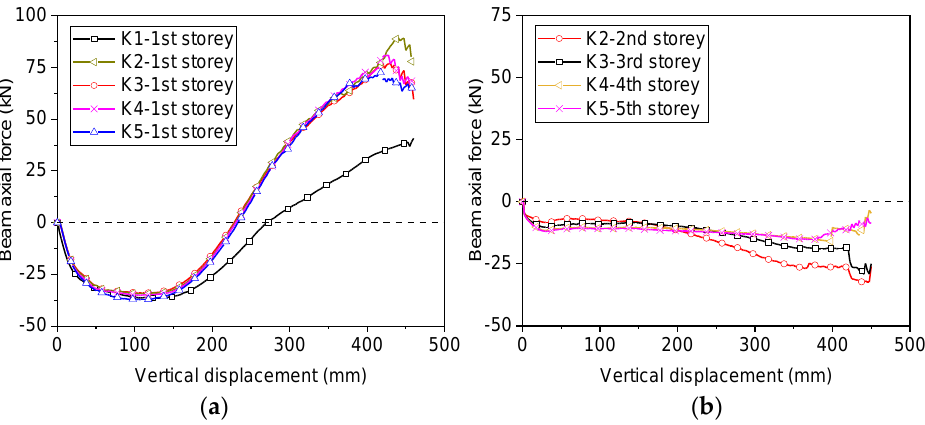
Figure 18. Variations in beam axial force at the first and top storeys: ( a ) beam axial force at the first